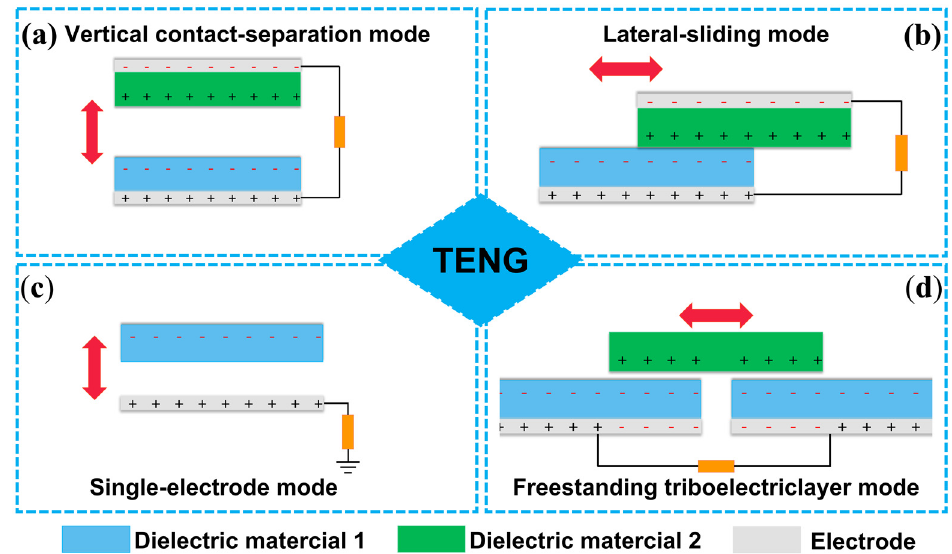
Figure 2. The four fundamental modes of TENG: ( a ) vertical contact-separation mode; ( b ) lateral- sliding mode; ( c ) single-electrode mode; and ( d ) freestanding triboelectric layer mode.